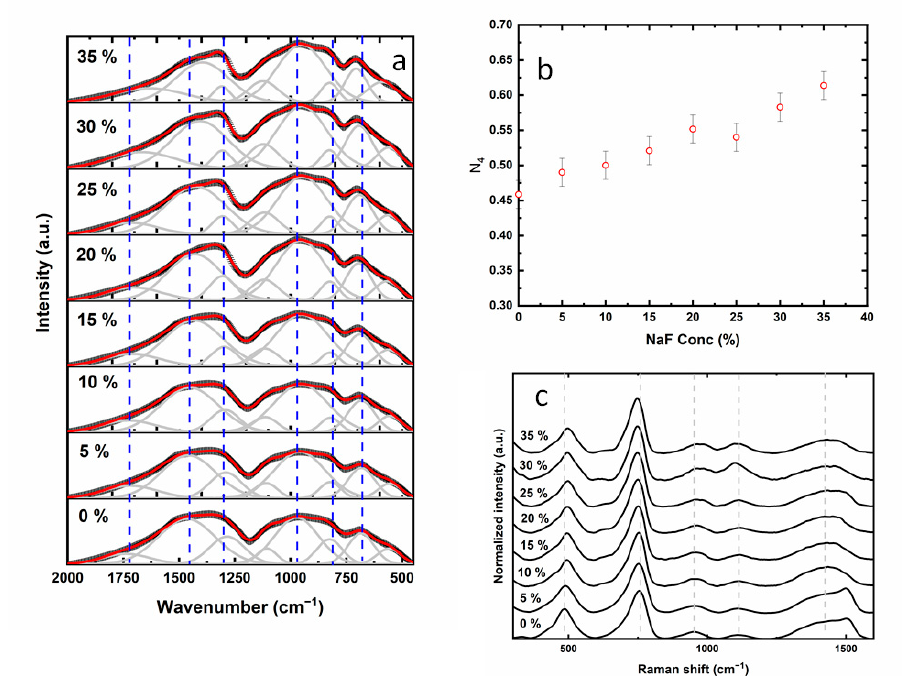
Figure 1. ( a ) FTIR experimental data are indicated with crosses, the convoluted bands are indicated in gray, and the adjusted spectrum is indicated in red. The blue shaded lines are to aid in visualization. ( b ) Evolution of the N 4 fraction as a function of the NaF concentration with the corresponding error bars. ( c ) Raman spectra of the samples studied. Intensity was normalized, with respect to 760 cm − 1 band maximum, for better visualization. The gray shaded lines are to aid in visualization.